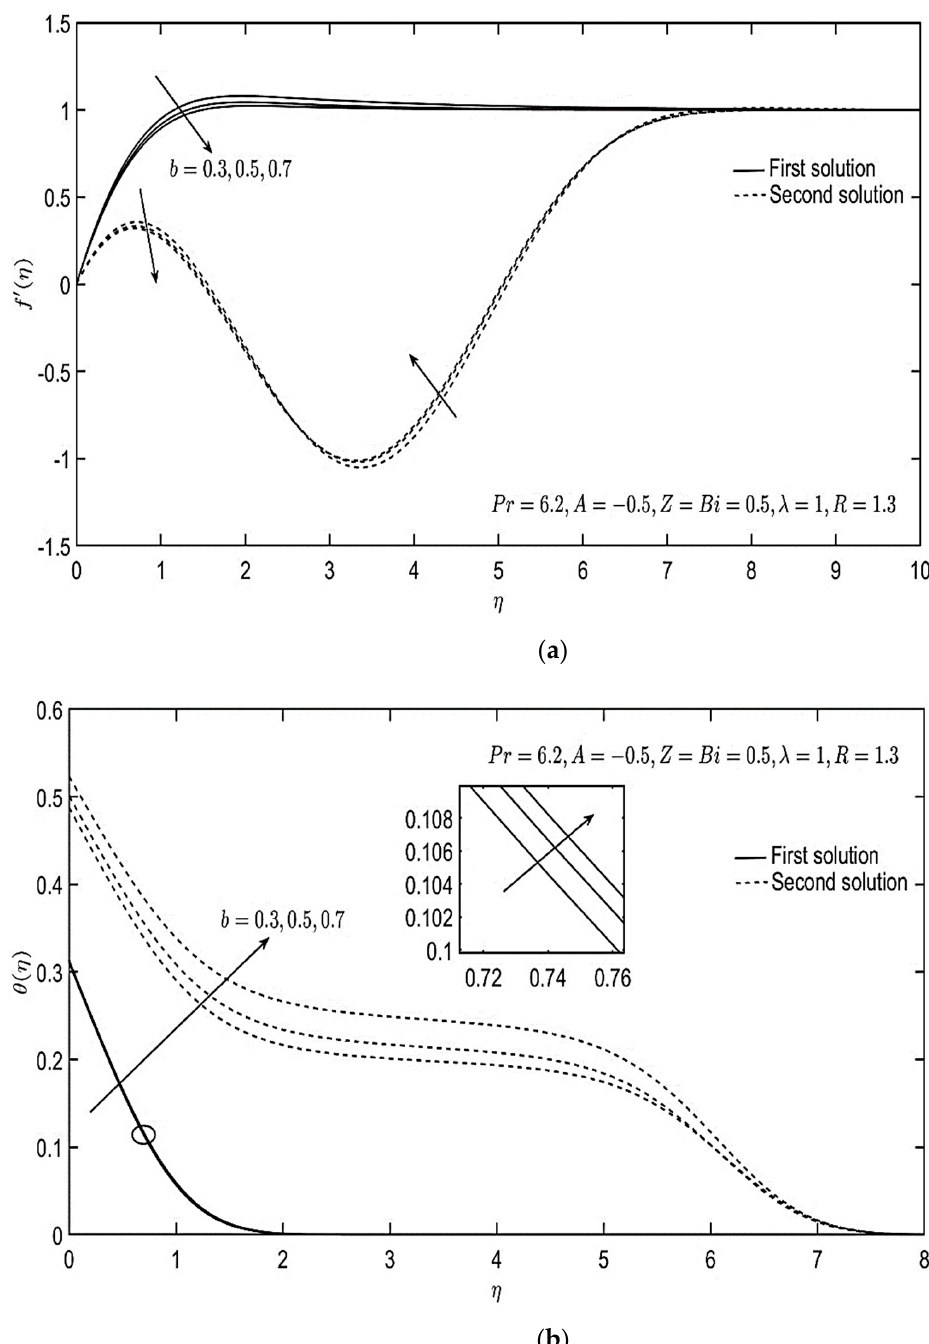
Figure 8. ( a ) Velocity and ( b ) temperature distributions for various values of 𝑏 .